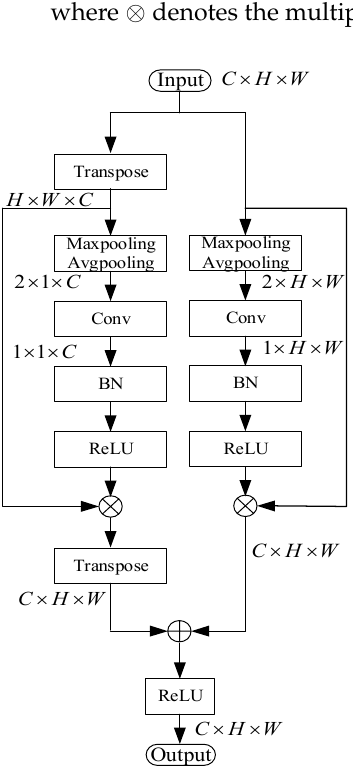
Figure 5. Structure diagram of the parallel attention module.